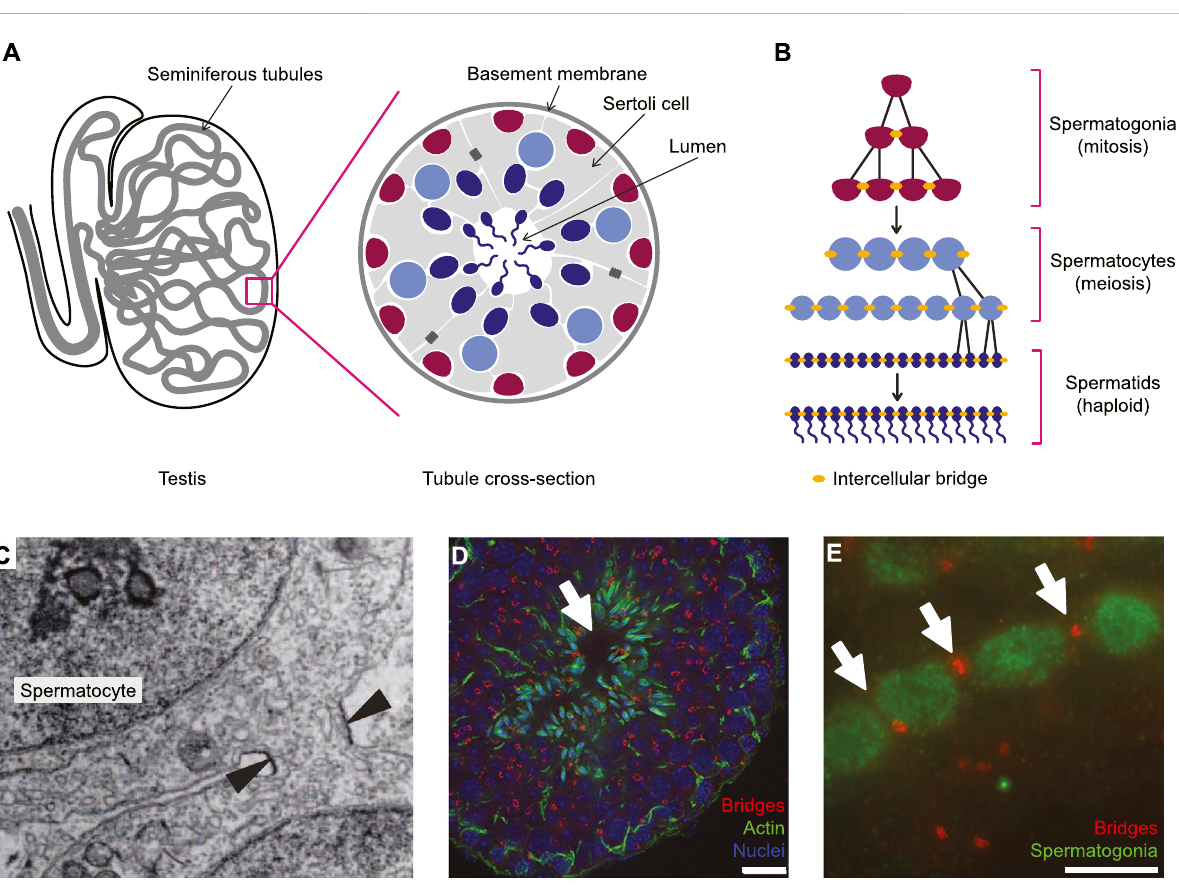
FIGURE 2 Intercellularbridgesduringspermatogenesisinthemousetestis. (A) Spermatogenesisoccurswithintheconvolutedseminiferoustubulesandis polarized, with mitotic spermatogonia at the basal surface and maturing spermatids at the luminal surface. (B) Both mitotic and meiotic divisions during spermatogenesis are incomplete and germ cells form long synchronous chains until individuation as mature sperm. (C) An electron micrograph showing a stable intercellular bridge (arrowheads) between two spermatocytes in the rat testis. Reproduced with permission from Dym and Fawcett, 1971. (D) A cross-section of a mouse seminiferous tubule stained for TEX14 to mark stable intercellular bridges (red), actin (green) and nuclei (DAPI, blue). Intercellular bridges are evident throughout the tubule. Arrow indicates the lumen. Scale bar is 25 μ m. (E) A higher magni fi cation view showing TEX14-labelled intercellular bridges (red; arrows) between spermatogonia (green) in the mouse testis. Scale bar is 10 μ m. (D) and (E) were adapted with permission from Greenbaum et al., 2006, Copyright (2006) National Academy of Sciences, United